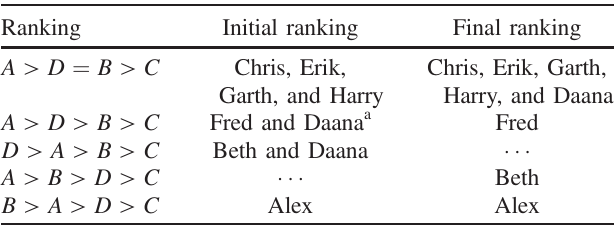
TABLE III. Summary of student entropy rankings for part A of the first question 1. All the rankings generated by students are listed in the leftmost